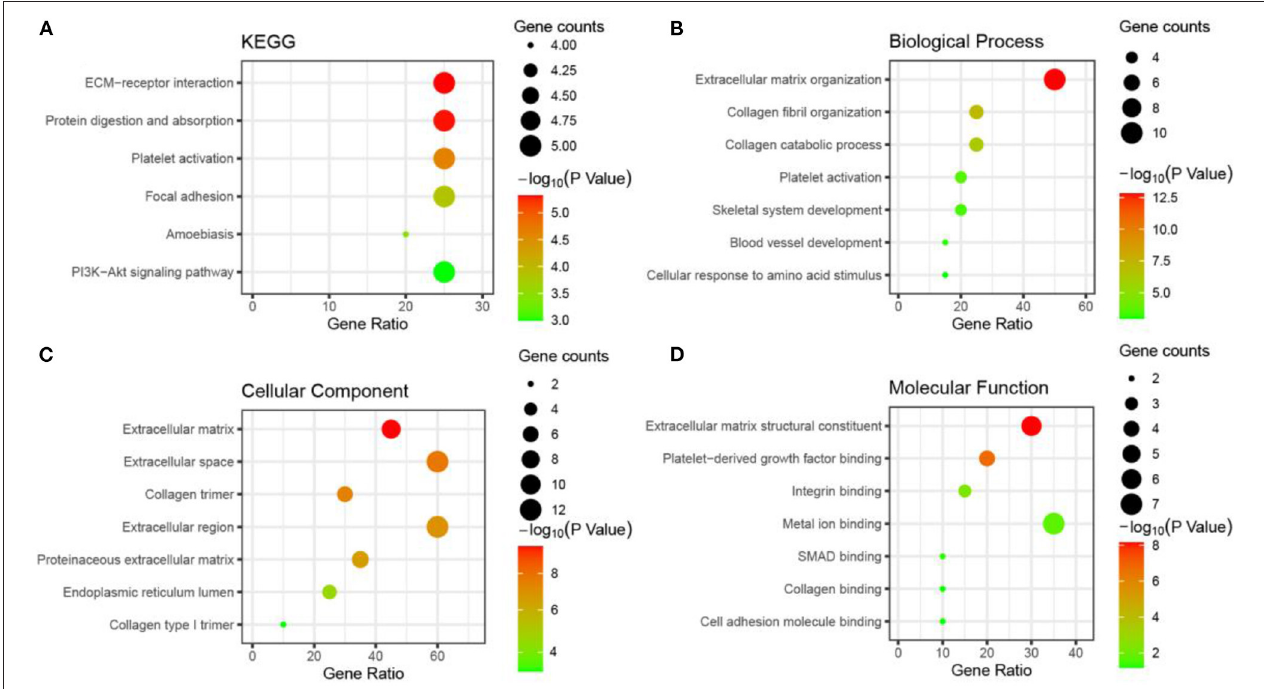
FIGURE 6 | Gene ontology and KEGG pathway enrichment bubble diagram for shared DEGs (showing the first seven